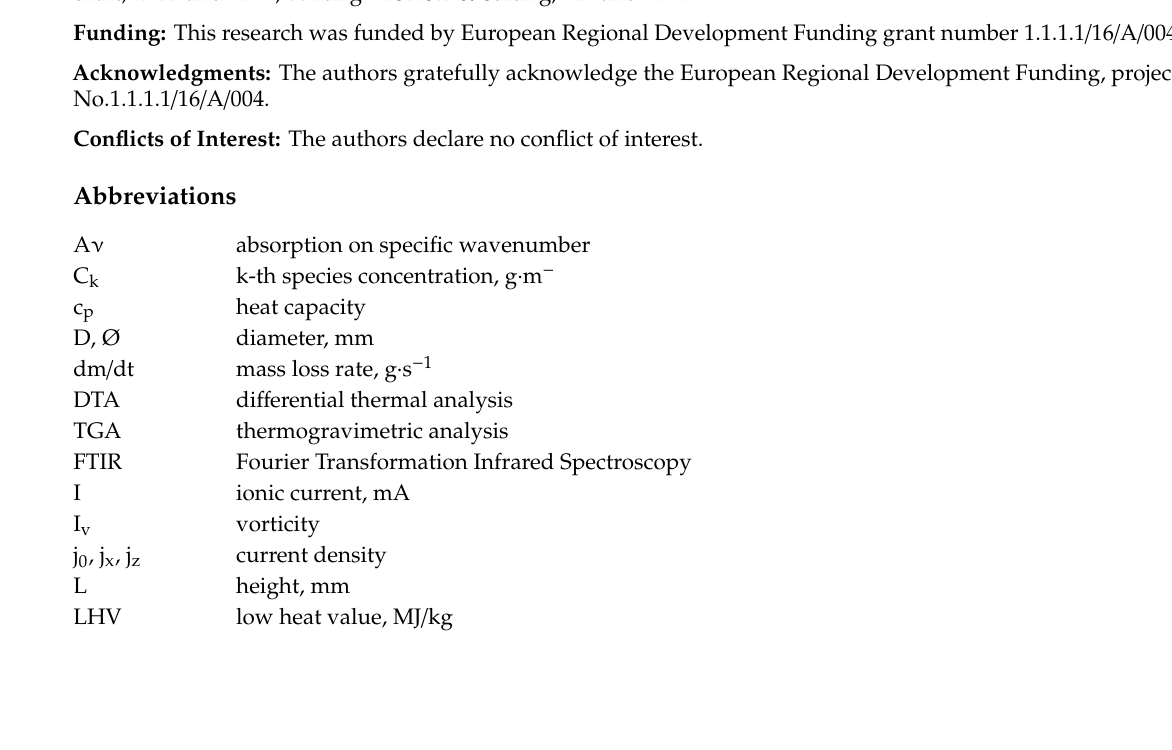
Figure S1: The diagram of a schematic description of the experiment, Figure S2: The technological scheme of the equipment and measurement instruments, discussion about the measurement data acquisition and accuracy, the experiment repeatability and